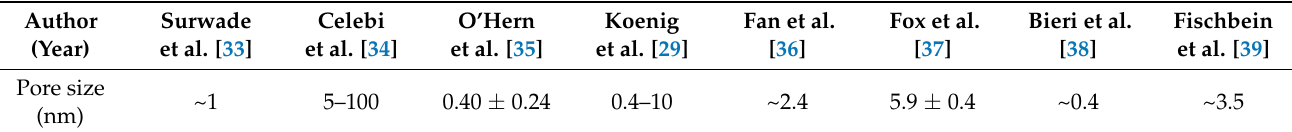
Table 2. Summary of experimental studies on nanopore generation in graphene from the literature